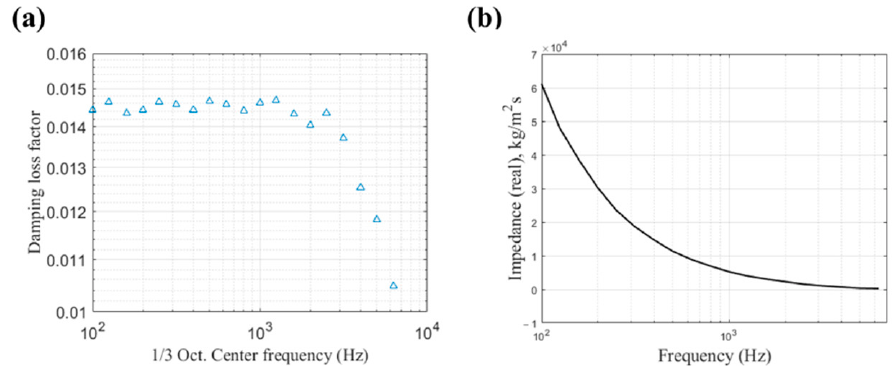
Figure 16. Damping loss factor and inner-wall impedance in acoustic cavity of HSM: ( a ) damping loss factor; ( b ) inner-wall impedance.